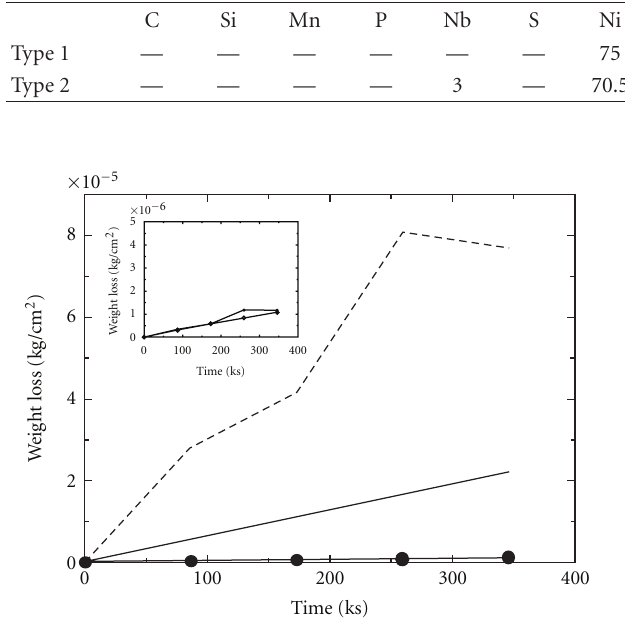
Figure 2: The weight losses of Ni 3 Al/Ni 3 V two-phase intermetallic compounds: • type 1, (cid:2) type 2, (solid line) Ni 3 (Si,Ti), and (dotted line) Type 304 as a function of immersion time in 0.5kmol/m 3 HCl solution at 303 K.